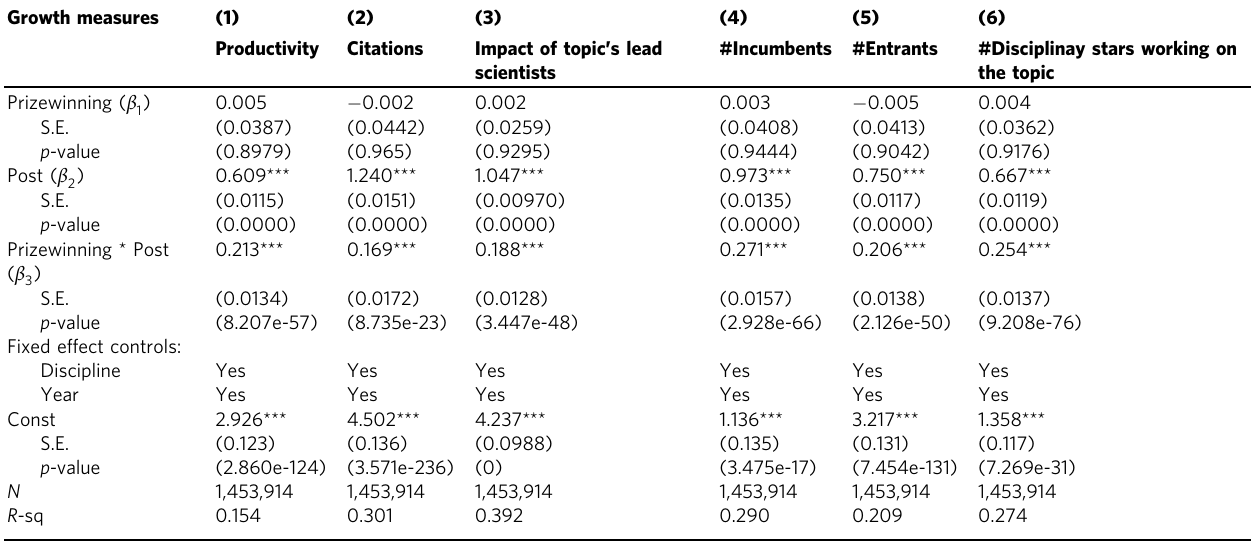
Table 1 DID regression of a topic ’ s comparative post-prizewinning growth on six measures. Growth